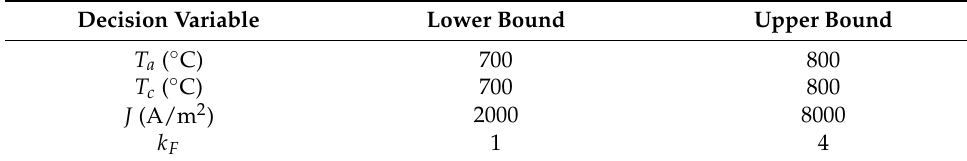
Table 2. The value ranges of the decision variables in optimization.